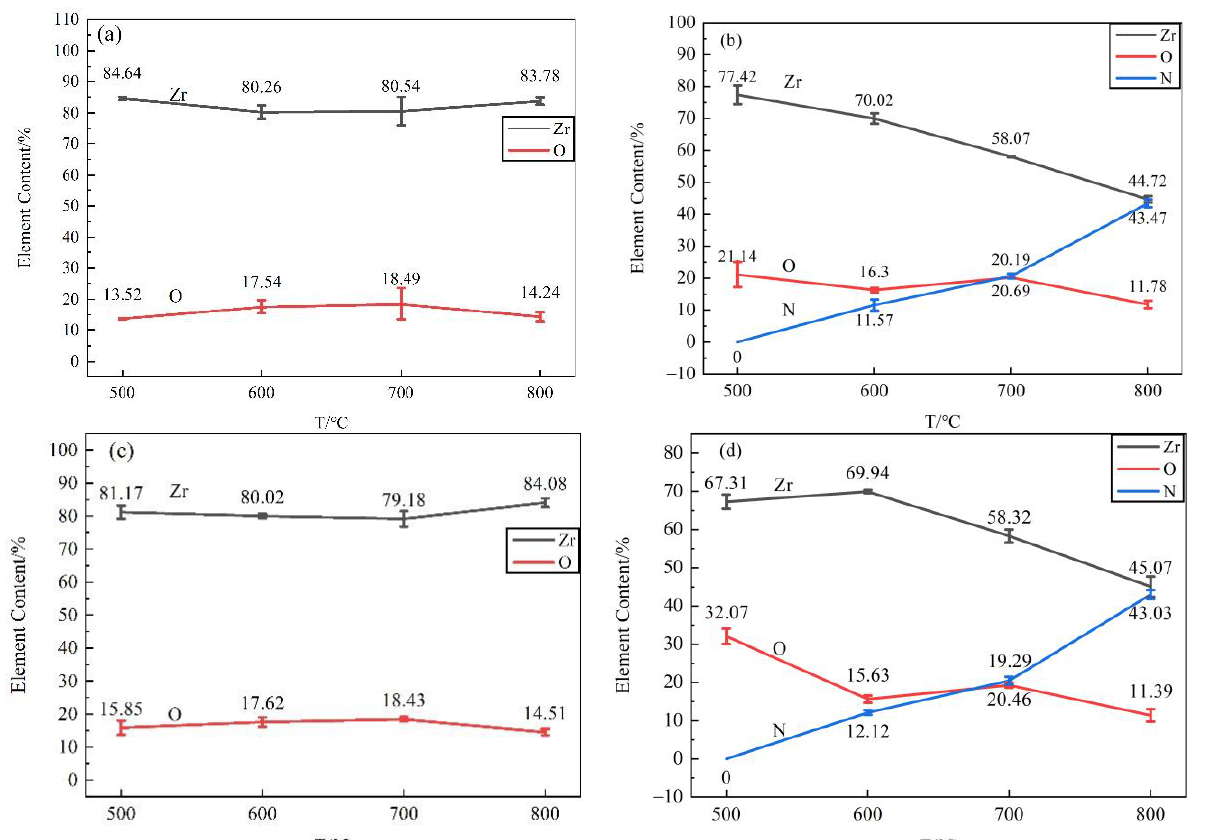
Figure 4. EDS analysis results of surface of zirconium hydride with nitride film ( a ) N 2 atmosphere; ( b ) N 2 + H 2 atmosphere.